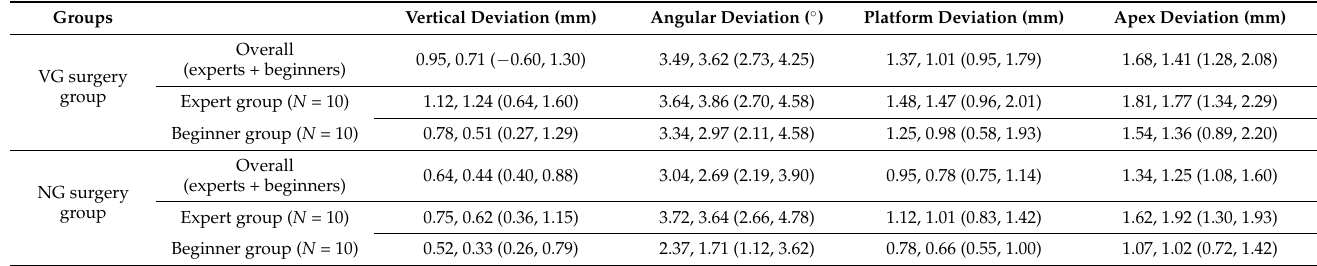
Figure 4. Box-and-whisker plots showing positional accuracy of the implant fixtures. ( a ) VG surgery group versus NG surgery group. ( b ) Expert group versus beginner group within VG surgery and NG surgery each; VG surgery group versus NG surgery group within expert group and beginner group each. The whiskers above and below the box show the minimum and the maximum, respectively, and the upper and lower bars of each box represent the first and third quartiles, respectively. The horizontal line within each bar means the median value, while the “x” mark denotes the mean value. The circular points placed above and below the whiskers depict the outliers if applicable. Table 2. Accuracy analysis of the implant position (mean, median (95% confidence